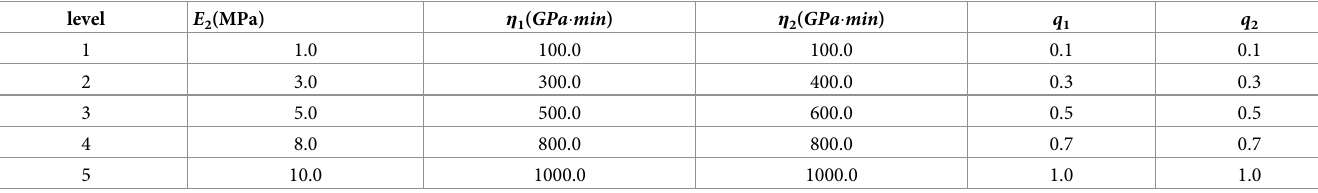
Table 3. Parameter levels of the fractional differential constitutive model of soft clay.